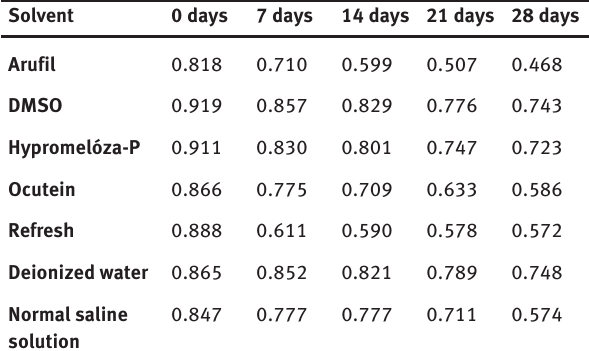
Table 1: Absorbance of 50 μM fisetin main peak in the eye drops (Arufil, Refresh, Ocutein, Hypromelóza-P), dimethylsulphoxide (DMSO), deionized water and normal saline solution (NSS) after 0, 7, 14, 21 and 28